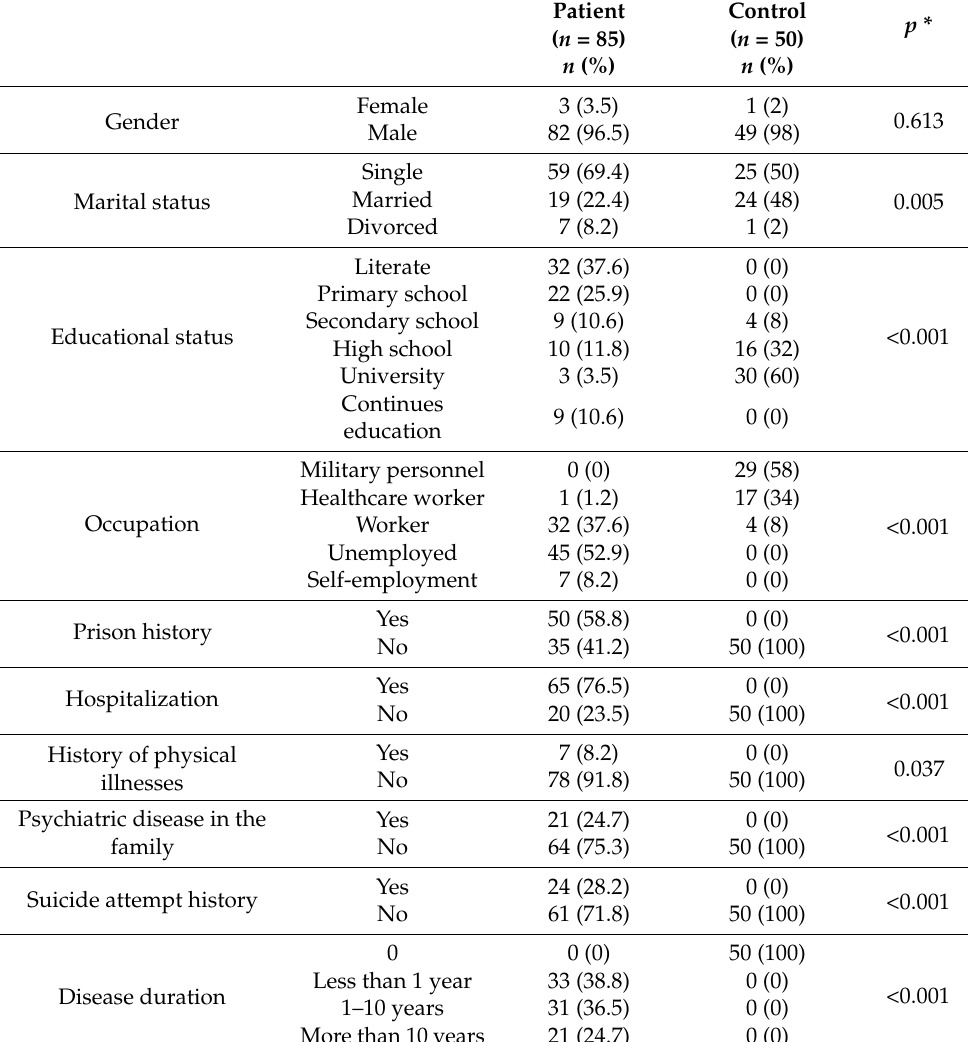
Table 1. Sociodemographic and clinical characteristics of the patient and control